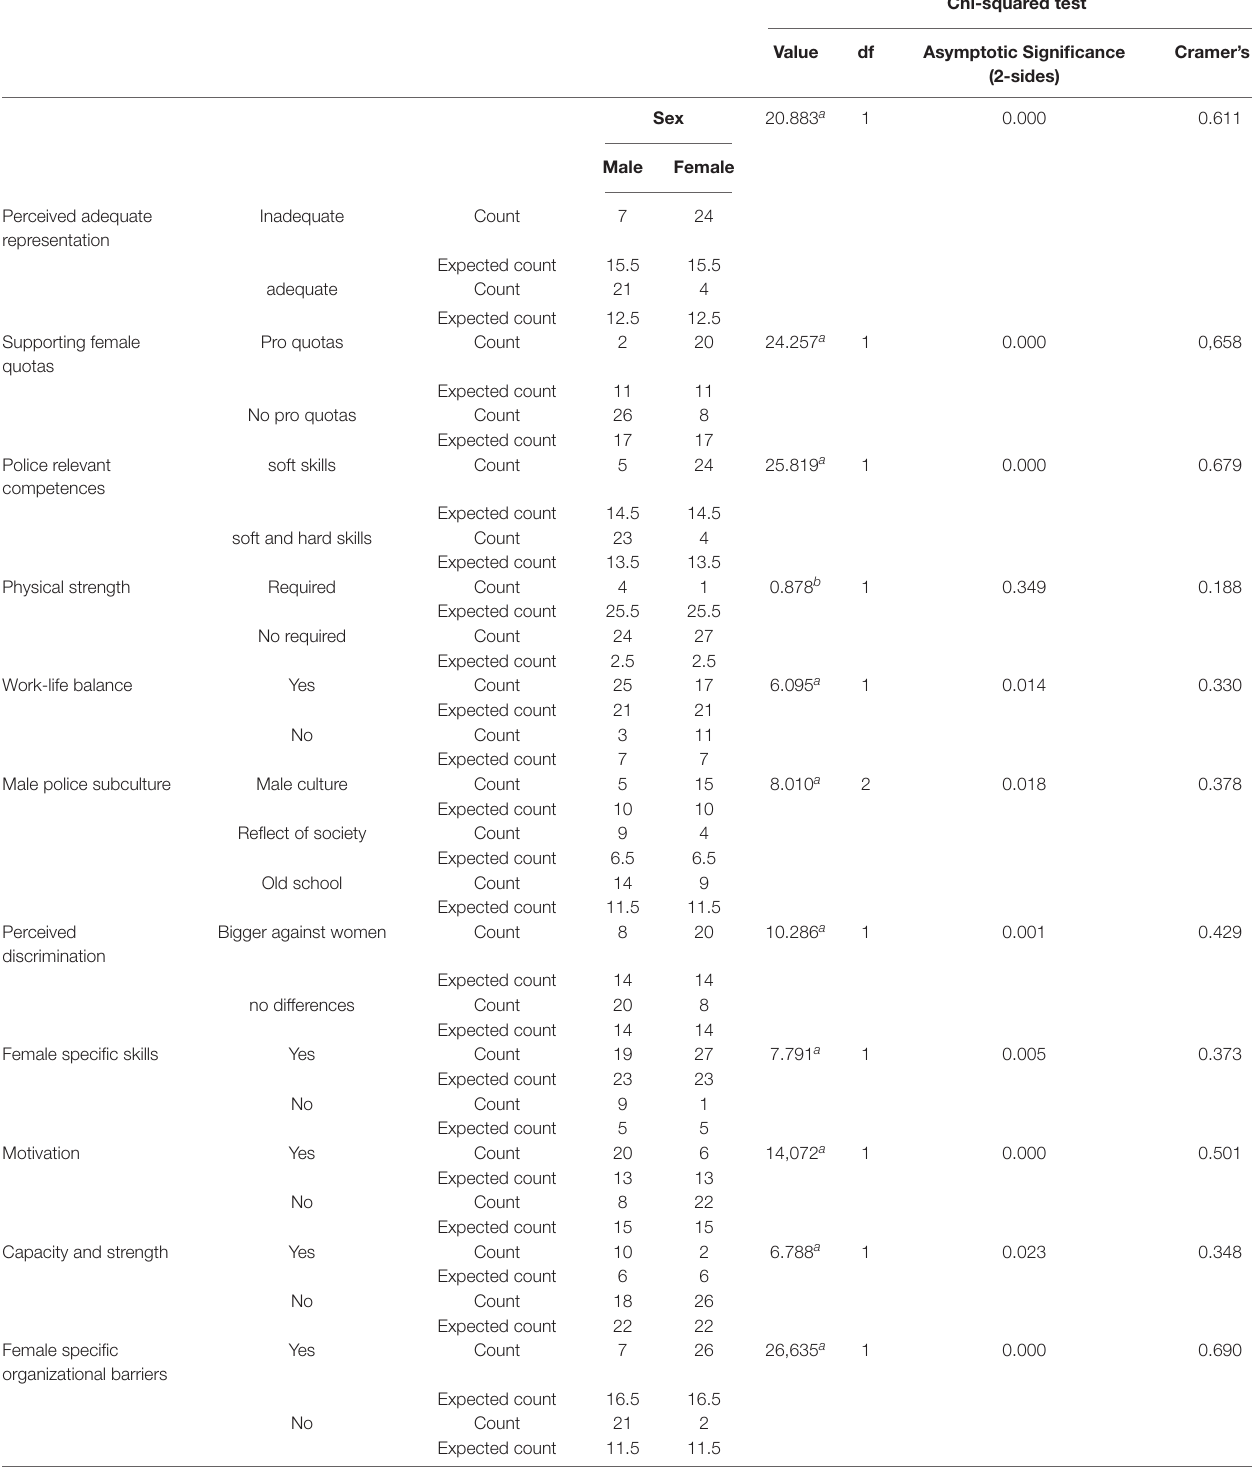
TABLE 4 | Frequencies of second-order codes and Chi-square